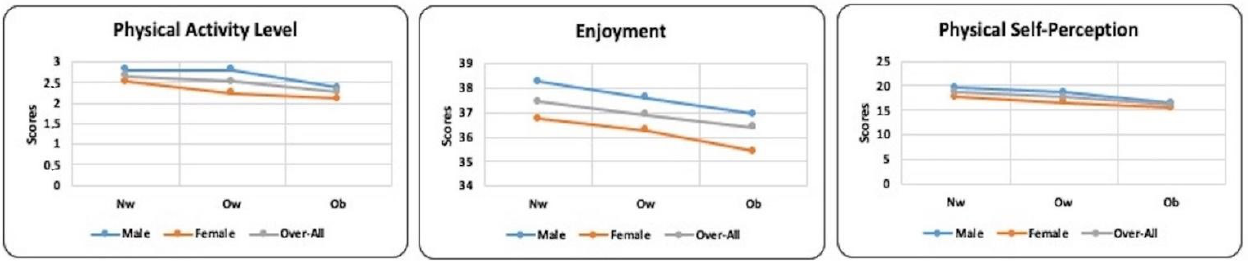
Figure 3. Levels of physical activity, enjoyment, and physical self-perception in males, females, and overall sample according to BMI cutoff. Table 2. Measures of Physical Activity Level (PAL), Enjoyment, and Physical Self-Perception (PSP). Nw